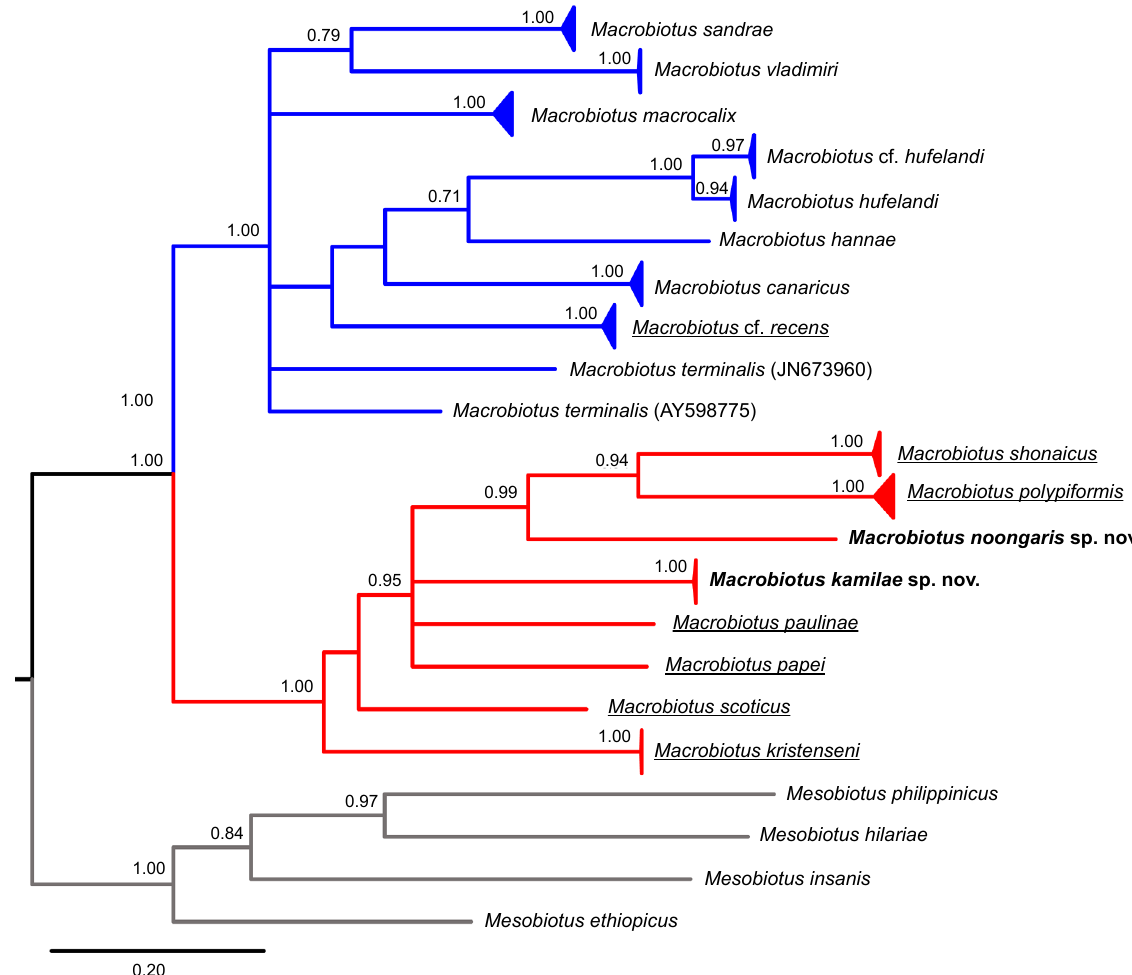
Fig. 16. The Bayesian Inference (BI) phylogeny constructed from COI sequences of the Macrobiotus hufelandi group species. Numbers at nodes indicate Bayesian posterior probability. Two previously recognized clades, one grouping mostly species with typical inverted goblet-shaped processes and the second grouping mostly species with morphological modifications of egg processes, are marked in blue and red, respectively. Species of the hufelandi group with atypical egg processes are indicated by underlined font. Please see Appendix 1 for details on species sequences used in the analysis. The outgroup is marked with grey. The scale bar represents substitutions per